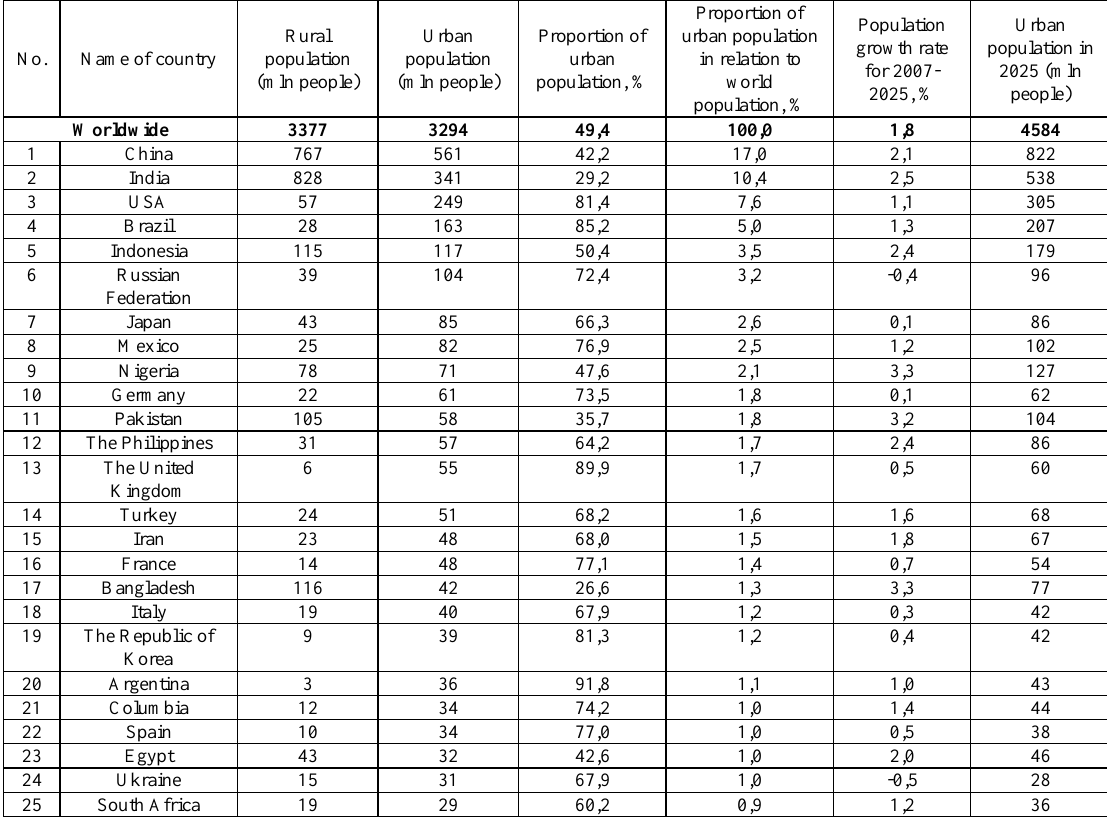
Table 3. Population Forecast for key countries of the world in